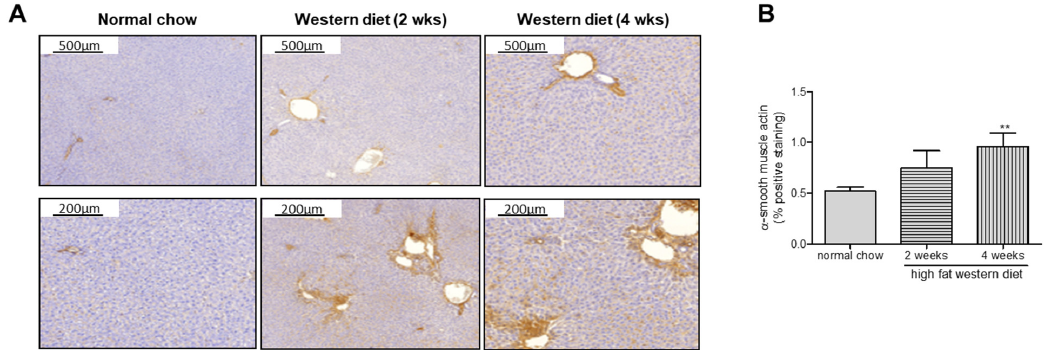
Figure 2. α -smooth muscle actin ( α -SMA) expression in transgenic TGR(mREN2)27 rats after high fat Western diet. ( A ) Hepatic α -SMA staining increased after 2 and 4 weeks of WD (left panel). ( B ) This